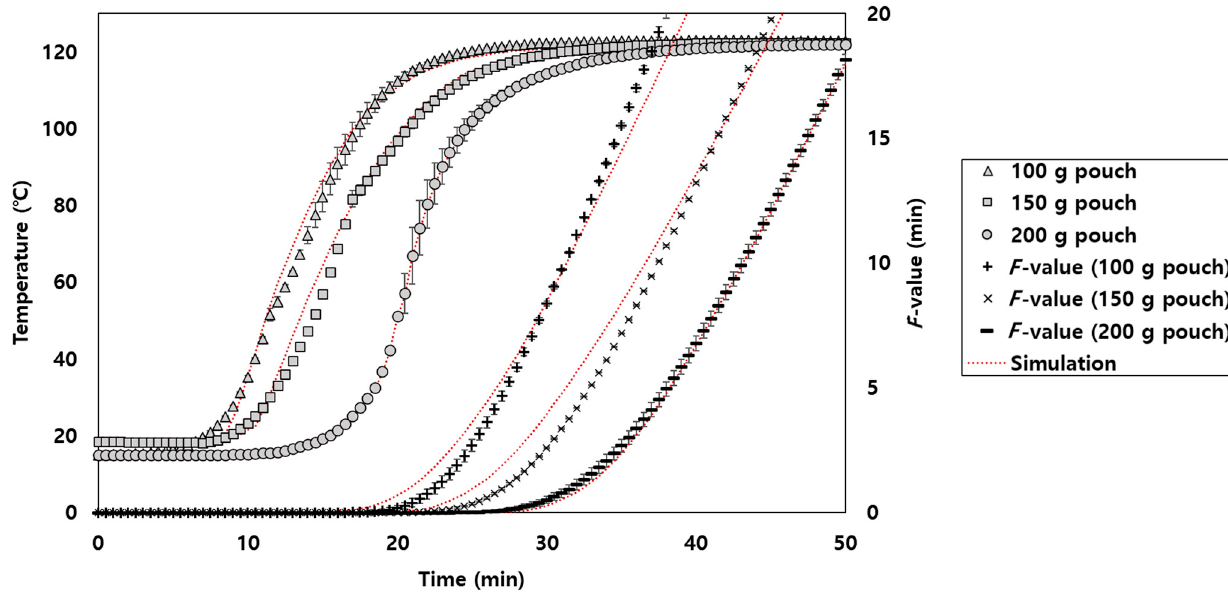
calculated F -values for packed BF at amounts of 100, 150, and 200 Figure 5. Temperature profile at the cold point obtained experimentally and by simulation and the calculated F ‐ values for packed BF at amounts of 100, 150, and 200 g.